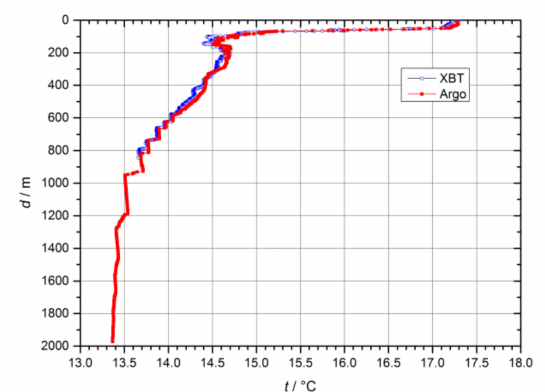
Figure 2. Spatial distribution of the XBT-Argo pairs analyzed along the MX04 transect in about 15 years.